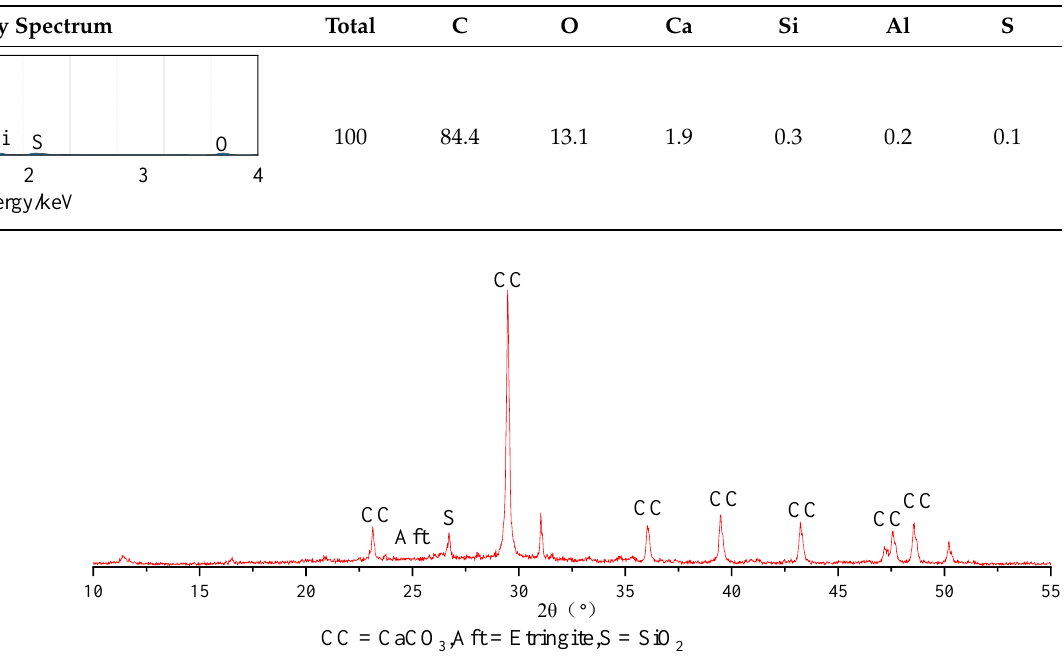
Figure 3. ( a ) Wastewater; ( b ) 8000 times magnified photo of wastewater particles. C-S-H = calcium silicate hydrate, CH = Ca(OH) 2 , CC = CaCO 3 . Table 3. Element analysis of wastewater particles (atomic fraction)/at %.